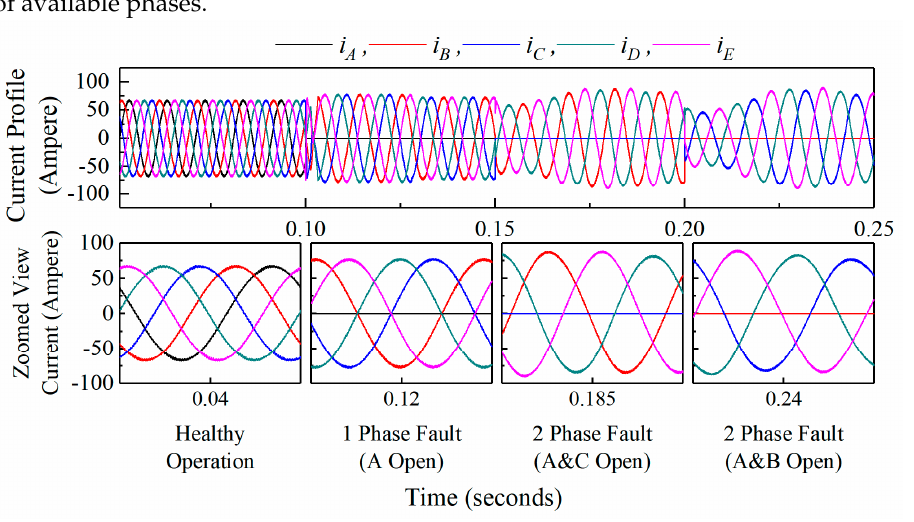
Figure 11. The current profile of a 5-phase PMSM.